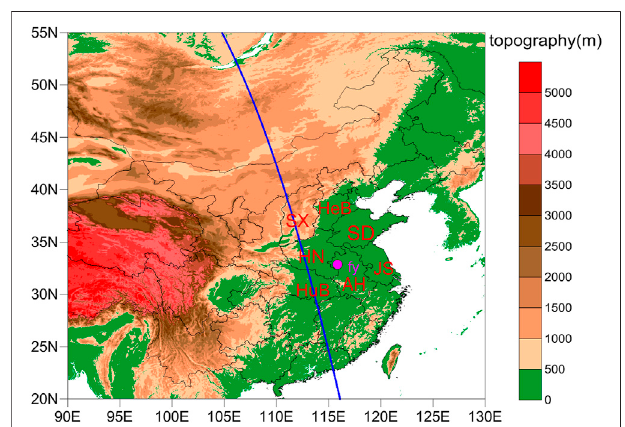
FIGURE 1 | The topography of Central East China, locations of representative cities and the CALIPSO satellite orbit used in this paper. The red letters indicate provinces (e.g., SX: Shanxi, HeB: Hebei, SD: Shandong, HN: Henan, HuB: Hubei, AH: Anhui, and JS: Jiangsu). The pink spot indicatesacity(fy:Fuyang).ThebluespotsindicatetheCALIPSOsatelliteorbit that passed over CEC on January